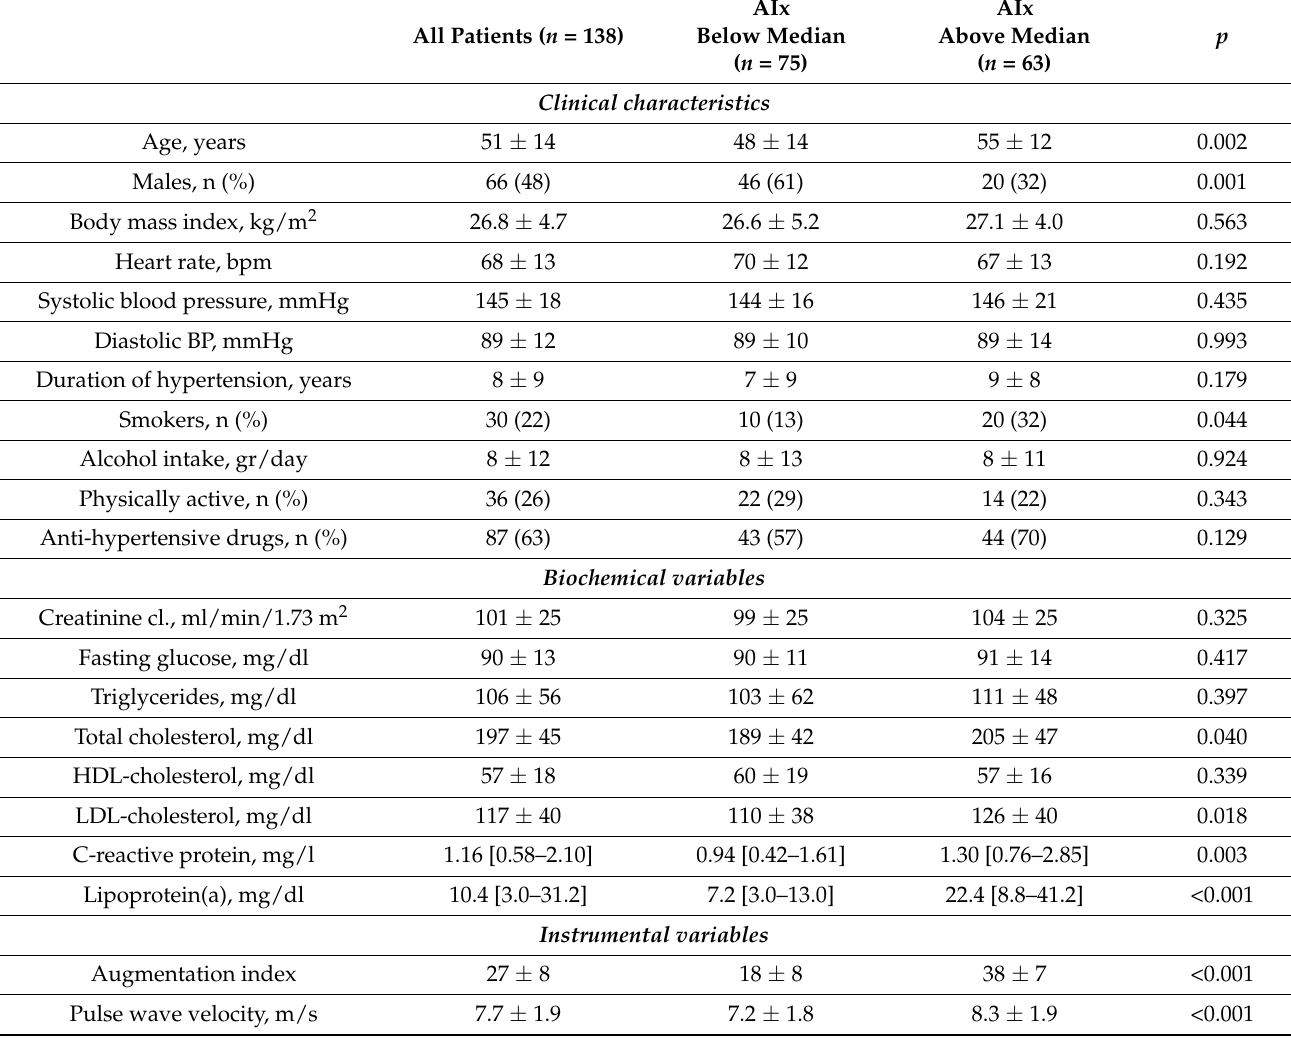
Table 1. Clinical characteristics and biochemical and instrumental variables of the study patients, subdivided according to the median value of augmentation index